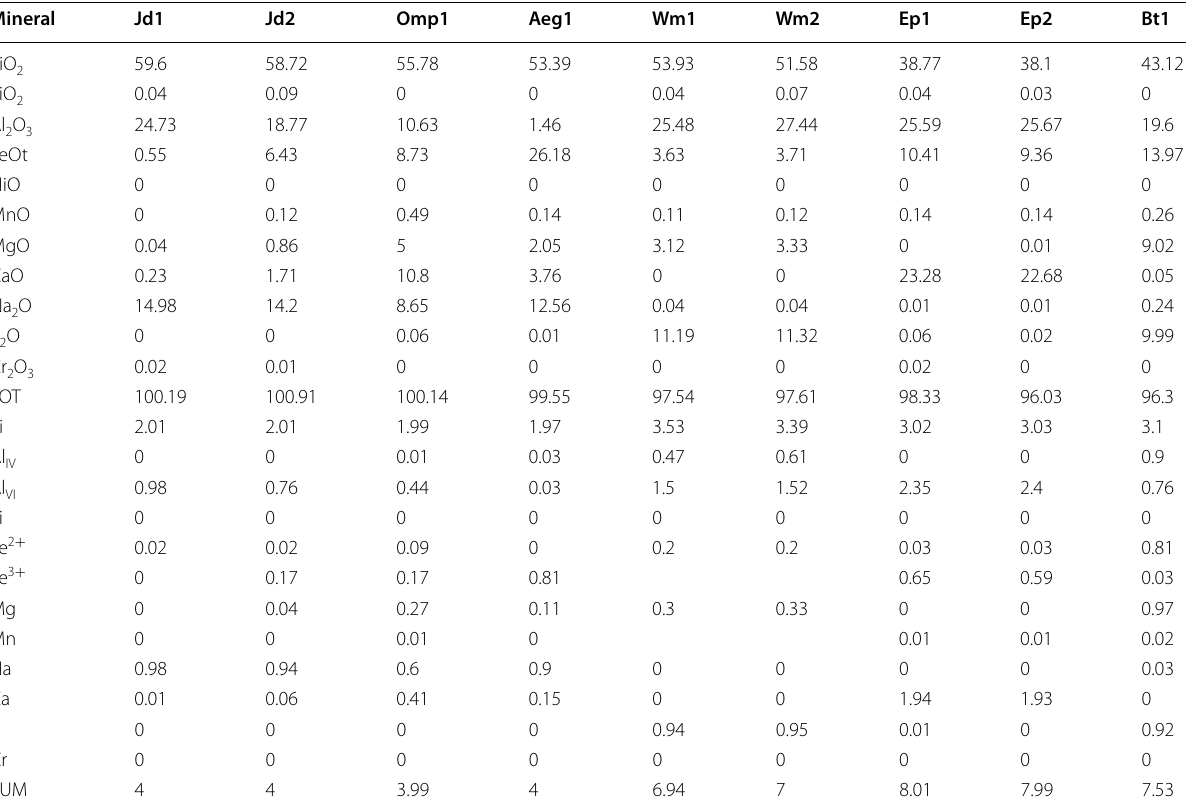
Table 6 Representative analysis of main minerals of garnet-free gneiss (CR115) Mineral Jd1 Jd2